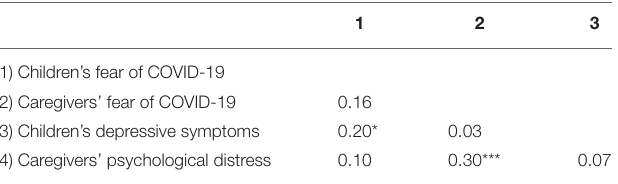
TABLE 7 | Pearson’s correlation among fears of COVID-19 and general mental health problems in children with neurodevelopmental disorder and their caregivers. 1 2